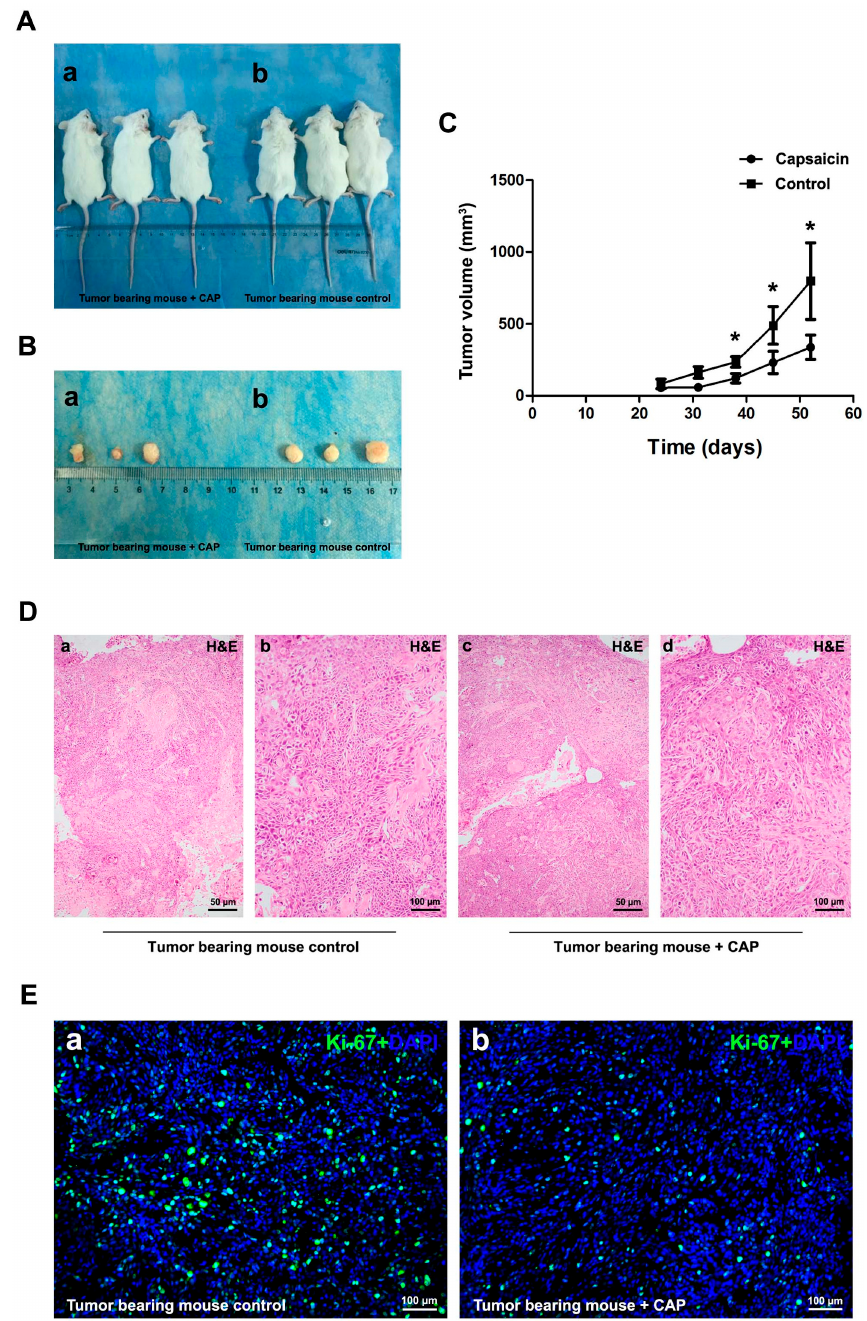
Figure 4. Delayed tumor growth after CAP treatment in vivo. ( A ) NOD/SCID mice were subcutaneously transplanted with 5637 cells for 21 days, and continuously injected into the peritumoral area by CAP for 28 days (a) compared with injection by saline containing 2.59% ethanol (b) as control; ( B ) Dissected tumor from the NOD/SCID mice injected by CAP (b) and saline containing 2.59% ethanol (a); ( C ) Statistical analysis of tumor size (mm 3 ) measured by a caliper and calculated using t -test, * p < 0.05. Days after 5637 cells transplantation, tumor size and control (saline containing 2.59% ethanol)/CAP injection were indicated; ( D ) Representative H & E staining of the tumor bearing mice control (a,b) and CAP injection (c,d) tissues. The scale bar for (a,c)are 50 µm and for (b,d)are 100 µm; ( E ) Cell proliferation of 5637 cells in vivo treated by control (a) and CAP (b) was detected by Ki-67 immunofluorescence staining (green). Nuclei were stained by DAPI (blue). The scale bar for (a,b) are 100 µm.